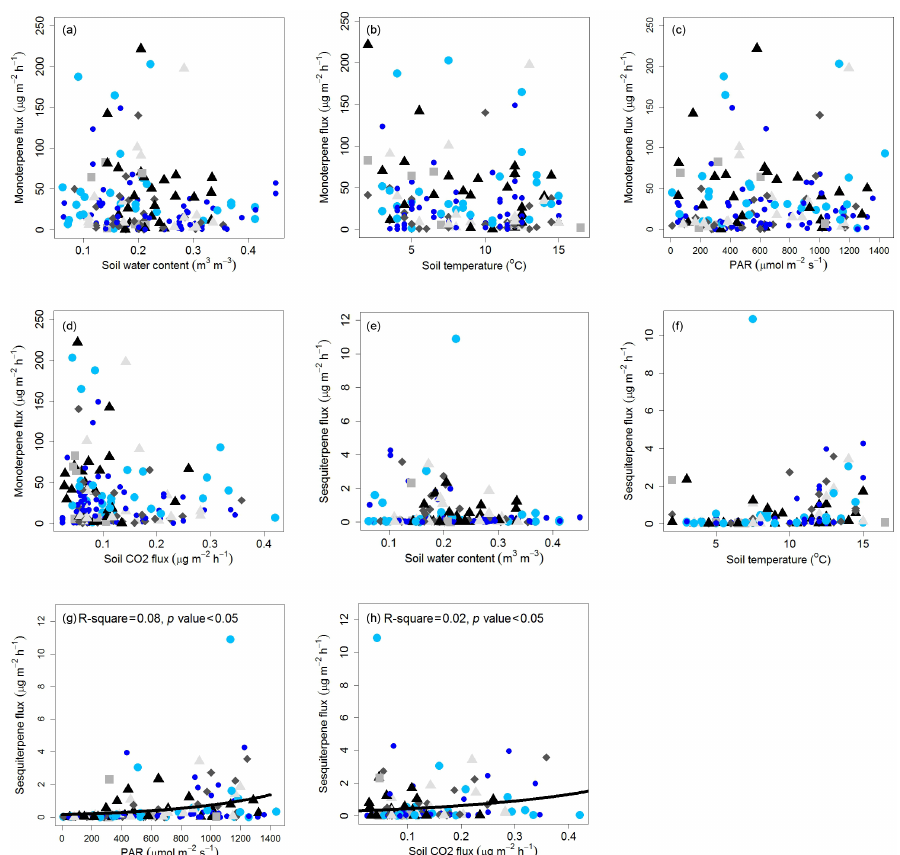
Figure A1. Relationships between monoterpene (a–d) and sesquiterpene flux (e–h) (µgm − 2 h − 1 ) and soil water content (m 3 m − 3 ) , soil temperature ( ◦ C), above-canopy PAR (µmolm − 2 s − 1 ) , and soil CO 2 flux (µgm − 2 h − 1 ) . The presented data were combined from all treat- ments (Control: soil was non-trenched, Tr50: the ingrowth of mycorrhizal fungi was allowed, and Tr1: decomposers were the only source) with vegetation ( + ) and those with bare soil ( − ). The treatments (Control += small blue circle, Control −= solid blue circle, Tr50 += filled gray triangle point-up, Tr50 −= filled gray square, Tr1 += filled gray diamond, and Tr1 −= filled black triangle point-up) were measured from April to October 2015. The regression coefficient and p value are indicated where the regression was